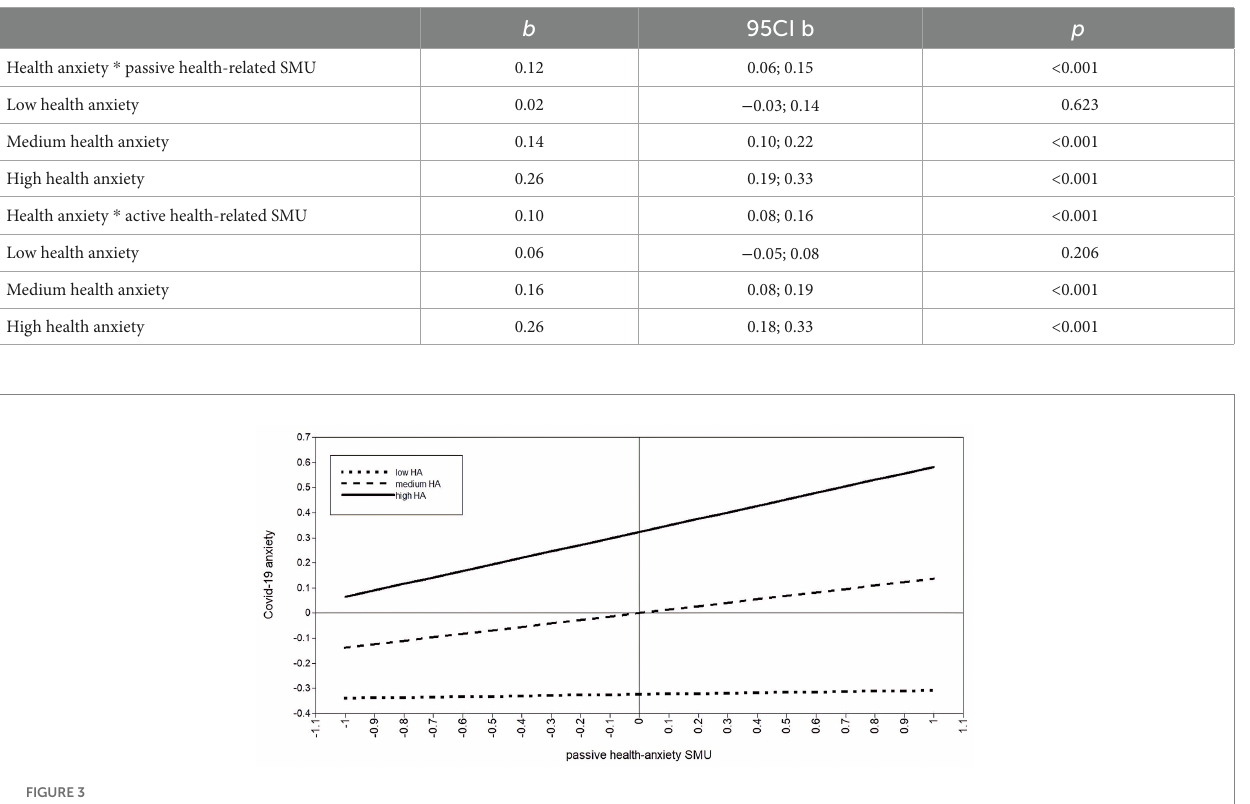
TABLE 4 The results of simple-slope analyses for both moderation effects.